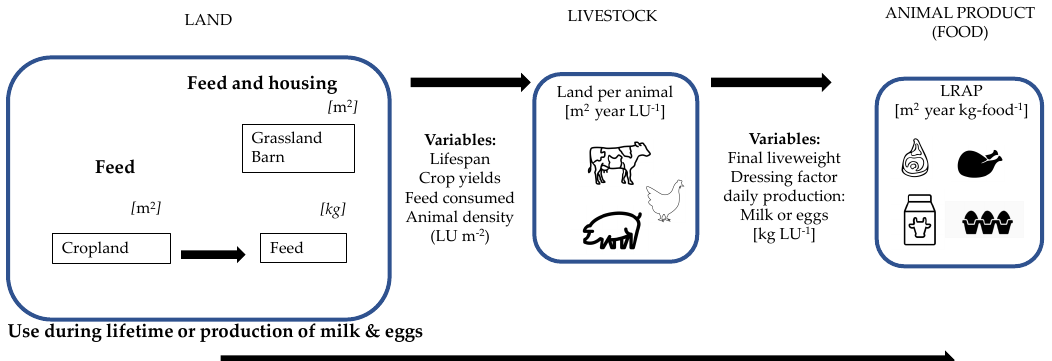
Figure 1. Calculation of the Land Requirements for Animal Products (LRAP). Source of icons: the Noun Project